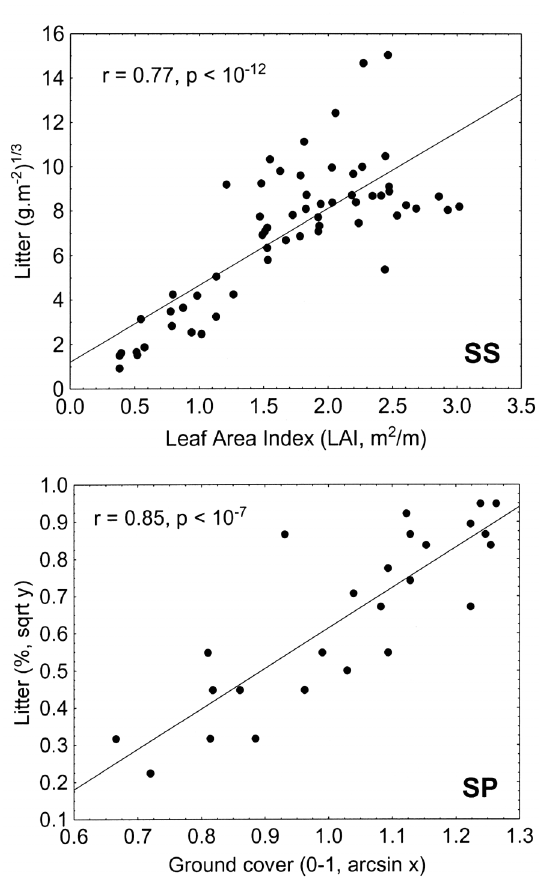
Fig 2. Scatterplots illustrating the closest linear relationships found between the measured canopy density variables and the litter accumulation variables in the soil of the forest sites located in southern Spain (SS, upper graph) and southern Portugal (SP, lower graph).